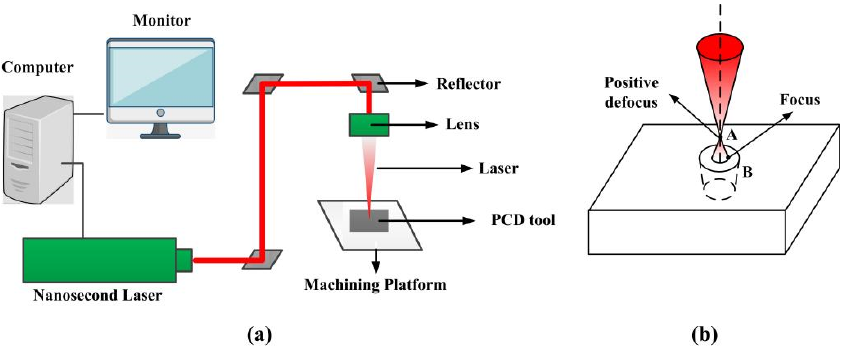
Figure 1. Schematic of ( a ) laser-control system and optical system, ( b ) schematic of laser machining.